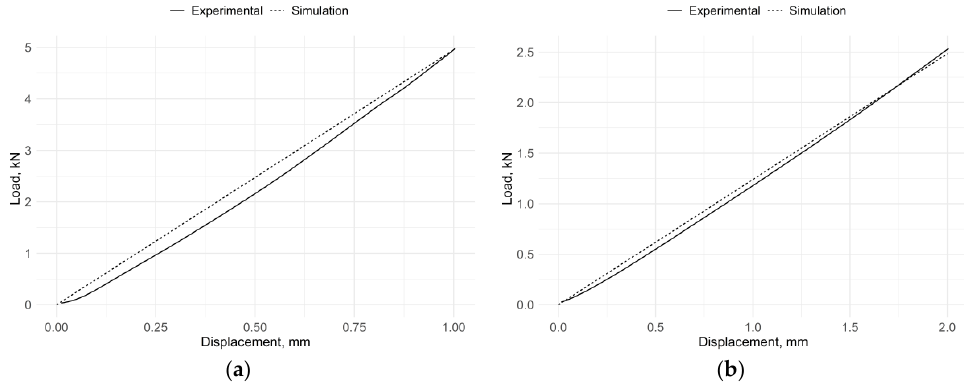
Figure 9. Load-deflection results for square cross-section blocks: ( a ) shape factor of 1.5; ( b ) shape factor of 0.75.